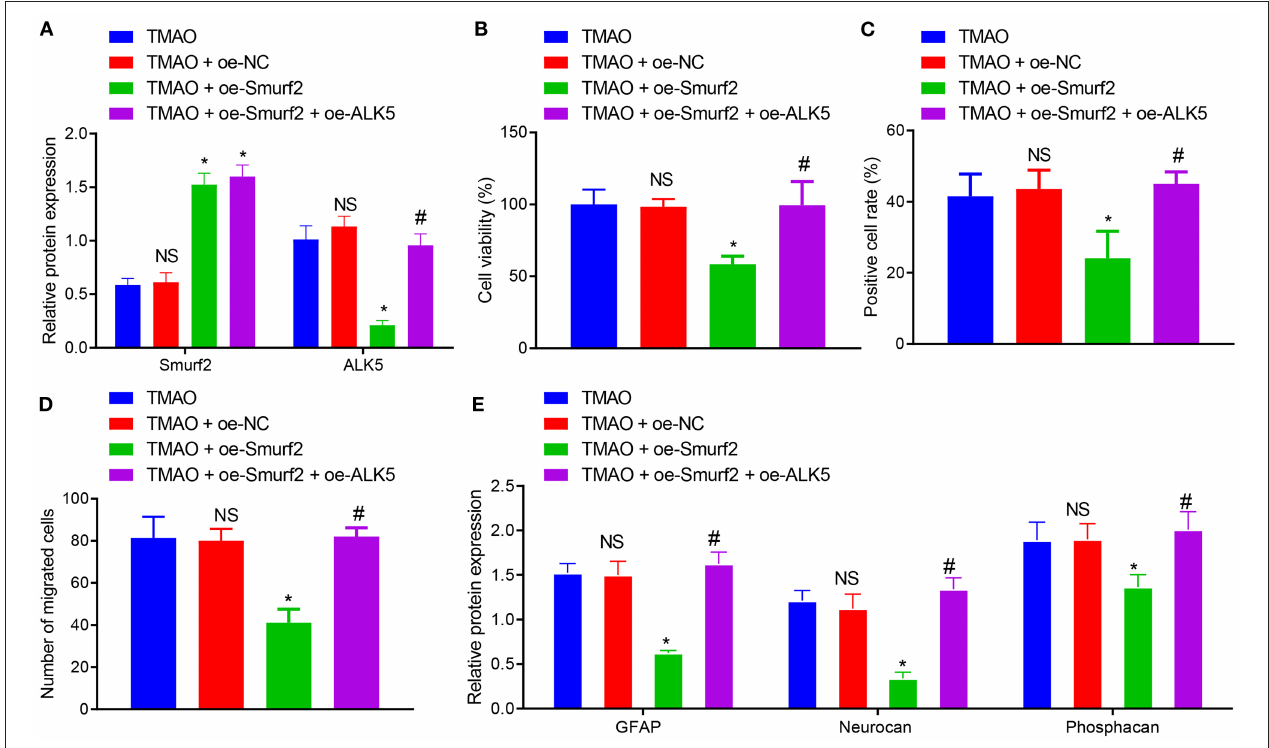
FIGURE 4 | Overexpression of ALK5 disrupts Smurf2-induced inhibition of astrocyte proliferation, migration and viability. (A) Expression of Smurf2 and ALK5 determined by Western blotting in each group of cells. (B) CCK-8 assay results of cell viability in each group. (C) EdU assay results of cell proliferation ability of each group. (D) Migration ability measured by Transwell migration assay in cells. (E) The expression of GFAP, Neurocan and Phosphacan in each group of cells detected by Western blotting. * p < 0.05 compared with the TMAO + oe-NC group. # p < 0.05 compared with the TMAO + oe-Smurf2 group. NS, p < 0.05 compared with the TMAO group. One-way ANOVA is employed for data comparison among multiple groups followed by Tukey’s post hoc